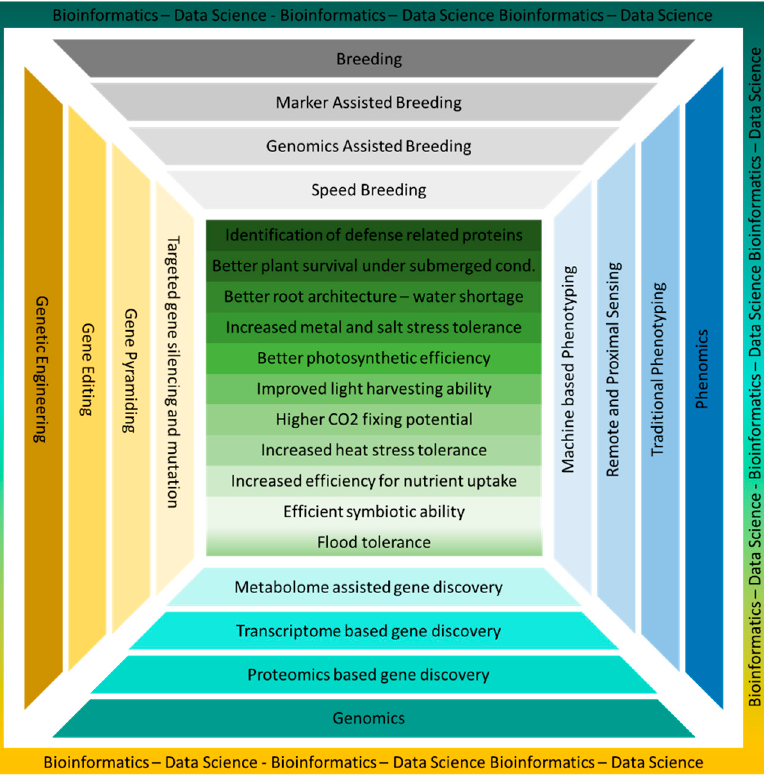
Figure 2. The agronomic traits (given in green boxes) of which improvement can significantly help in achieving higher yield goals in crop plants through the integration of techniques, i.e., plant breeding, genetic engineering, phenomics, and genomics represented by four sides. Bioinformatics and data science are two emerging disciplines that are helping to elaborate the large-scale plant genome/proteome/transcriptome/metabolome data in a meaningful way.